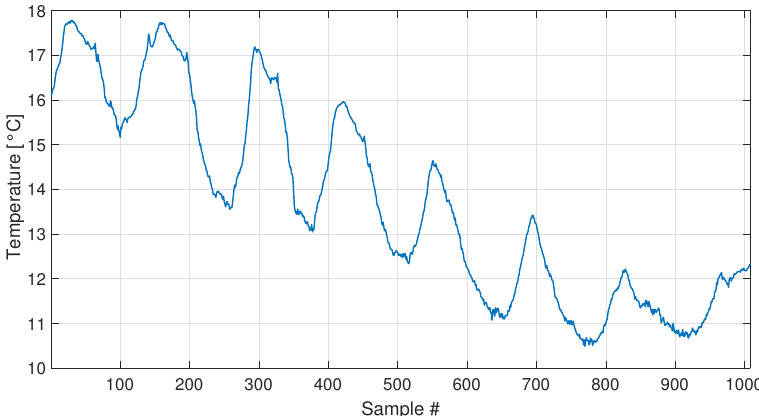
Figure 22. Temperature trend for the baseline set of real